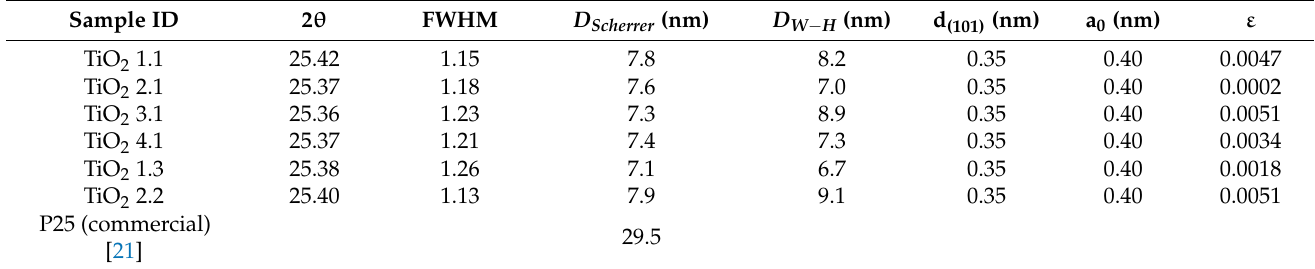
Table 1. Structural parameters * calculated using XRD data of the prepared titania samples.